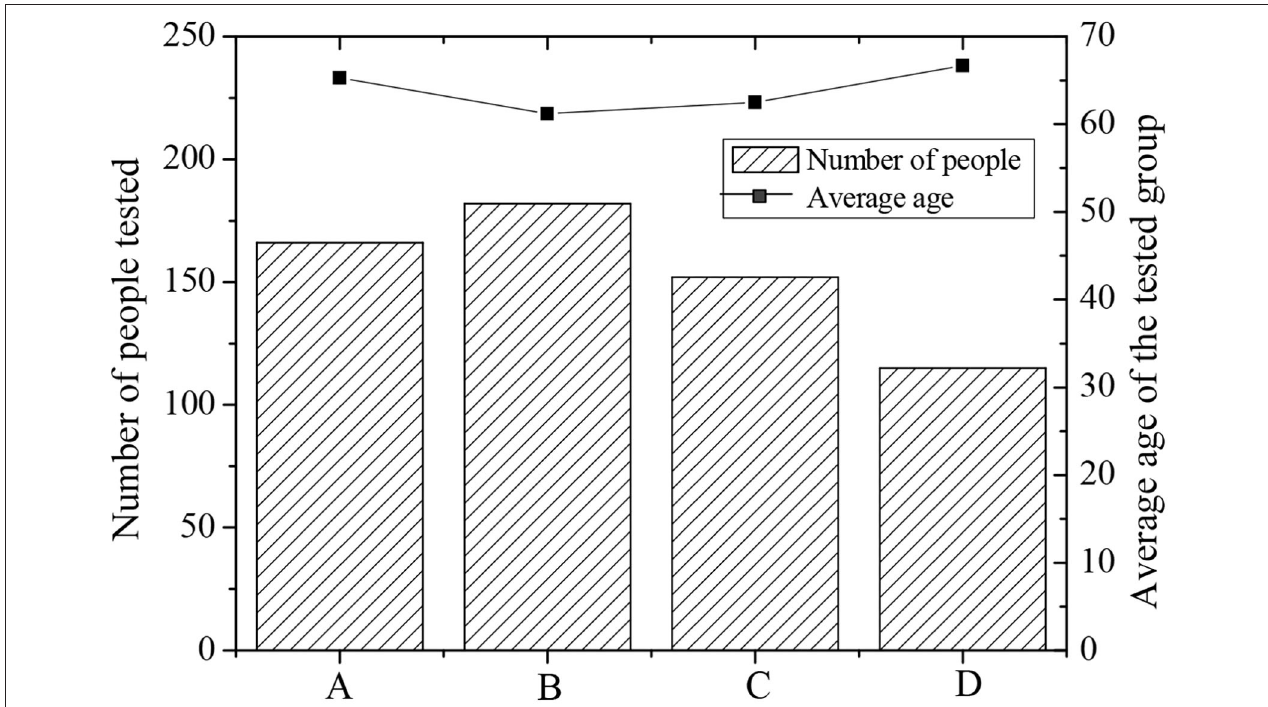
FIGURE 2 | The number of members of each group and the average age distribution (Group A: non-piano study group; Group B: study group < 2 years; Group C: study group with 2–5 years; Group D: study group with more than 5 years, Figure 3 ∼ Figure 5 the same).